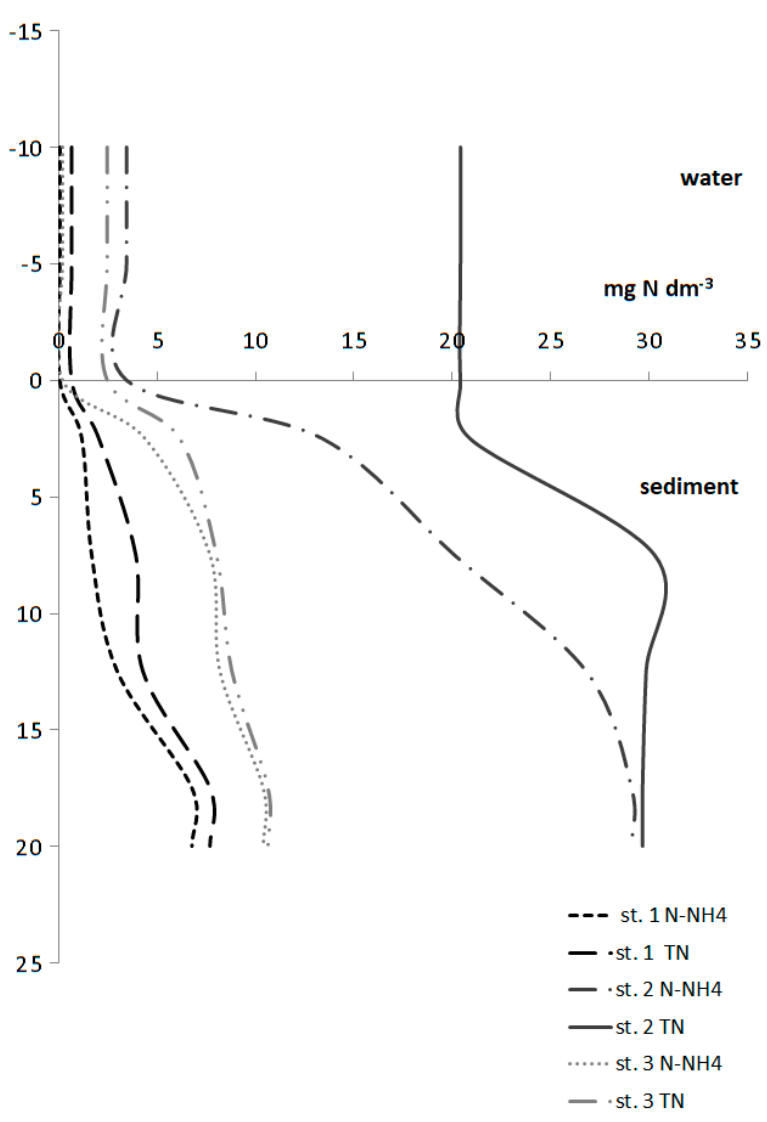
Figure 6. The total nitrogen (TN) and ammonia profiles in the water-sediment interface of D ł ugie